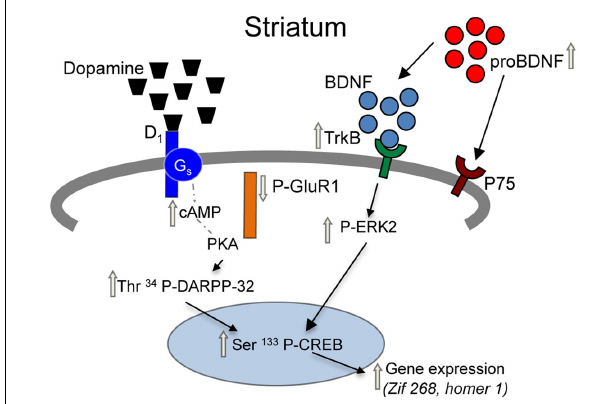
FIGURE 5 | Proposed model for adaptations in D1 receptor and BDNF signaling pathways in the striatum of prenatal cocaine treated mice. Prenatal cocaine treatment results in enhanced signaling via dopamine D1 andTrkB receptors in the striatum of adult mice via persistent adaptations in a coordinately regulated set of pre-synaptic, synaptic, and post-synaptic molecules. Gray arrows represent long-term adaptations seen in adult mice following prenatal cocaine